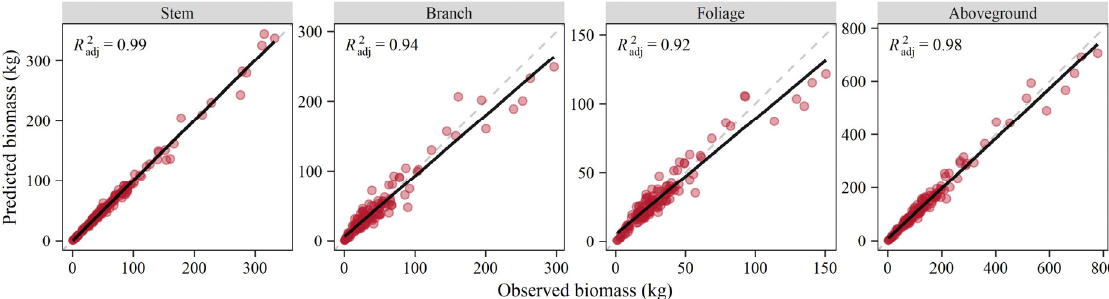
Figure 5. Relationships between observed and predicted biomass values obtained by jackknife procedure. Table 4. Cross ‐ validation statistics for component ‐ specific and total aboveground